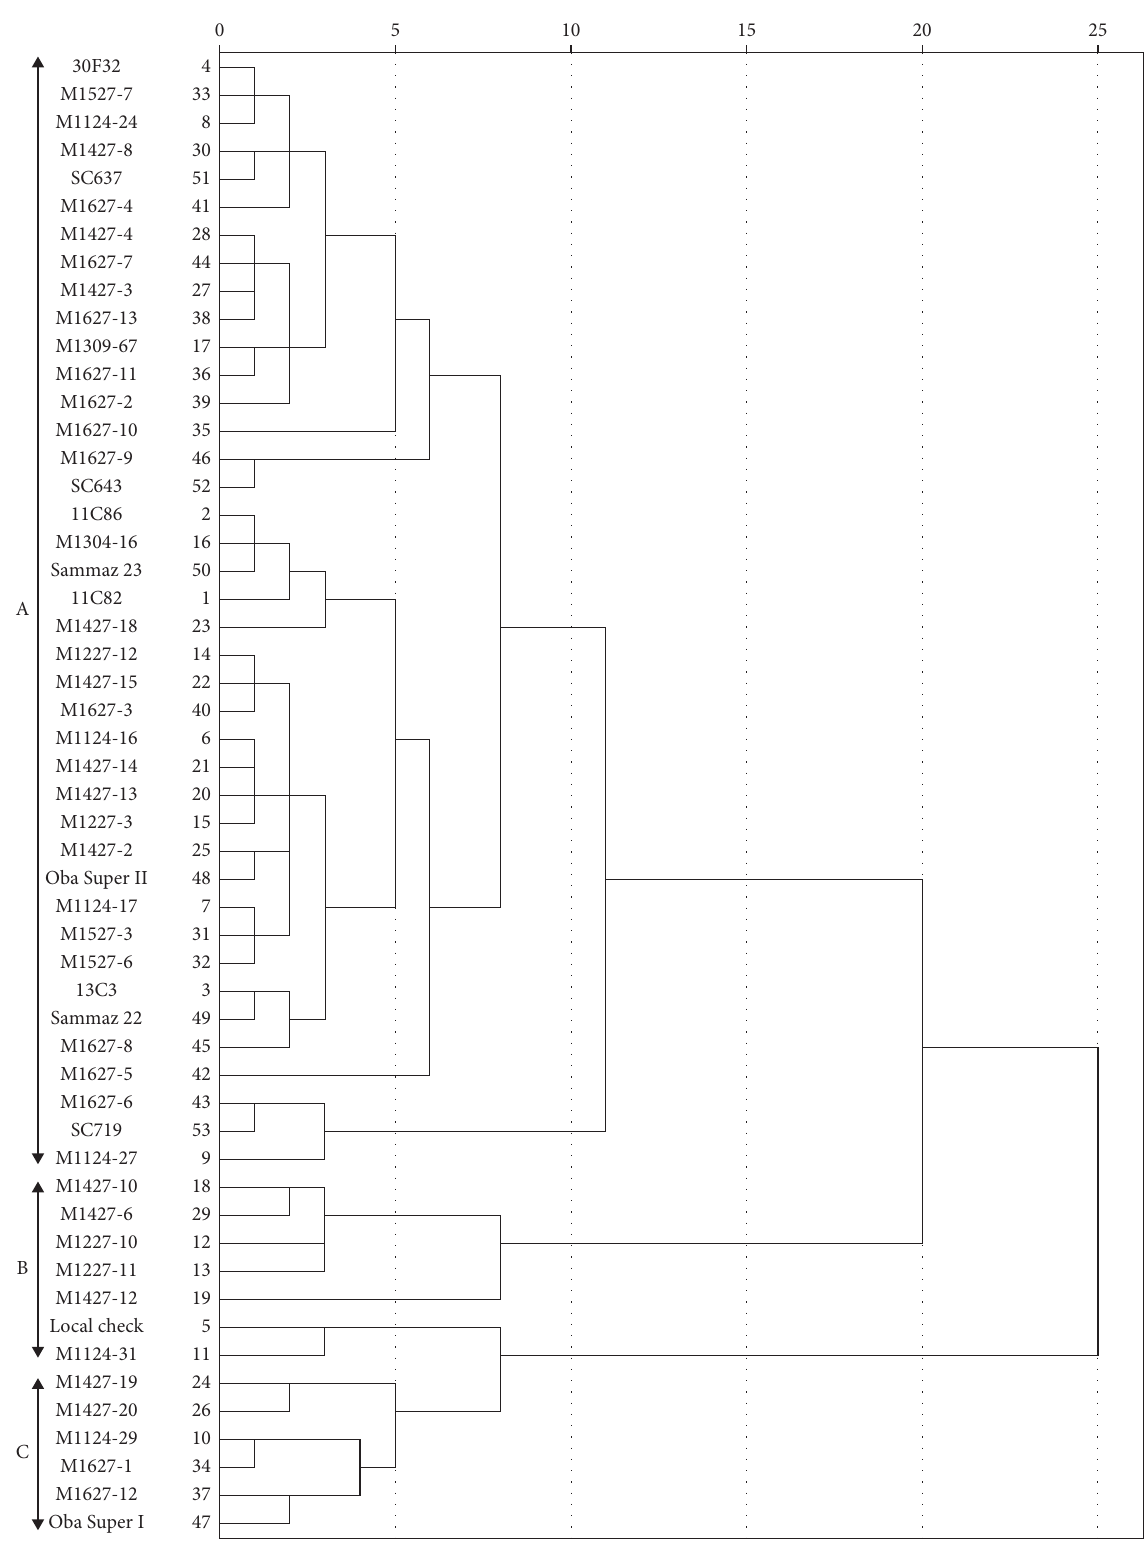
Figure 1: Dendrogram of 42 DT hybrids, 11 commercial hybrids, and a local check obtained for quality and quantity traits using cluster analysis of Euclidean distance